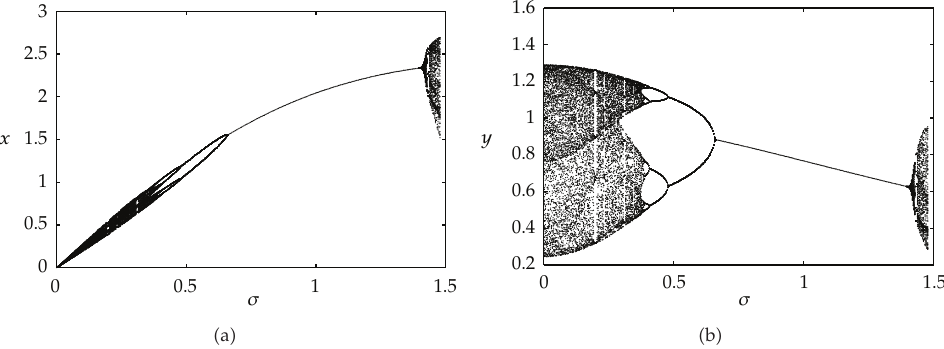
Figure 2: Bifurcation diagrams for the state variable x (cid:2) a (cid:3) and for the state variable y (cid:2) b (cid:3) , varying σ . The parameter values are α (cid:7) 0 . 12, β (cid:7) 0, γ (cid:7) 0 . 375, ρ (cid:7) 0, and r (cid:7) 2 .